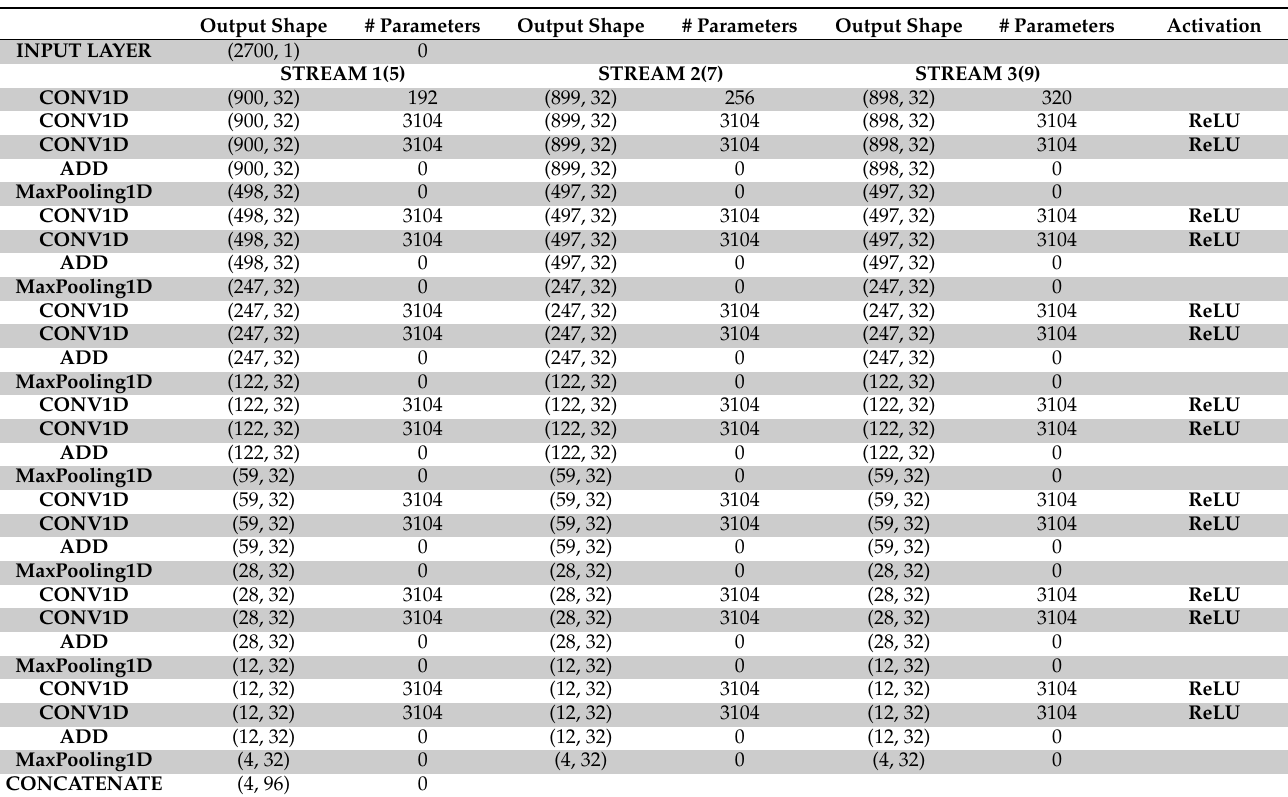
Figure 4. The workflow of the proposed atrial fibrillation (AF) detection method.